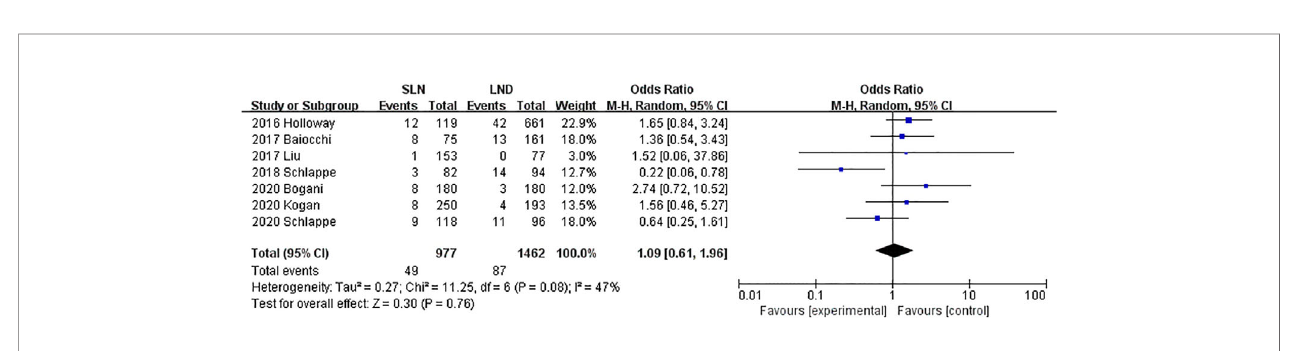
FIGURE 7 | Meta-analysis of para-aortic lymph nodes positive.